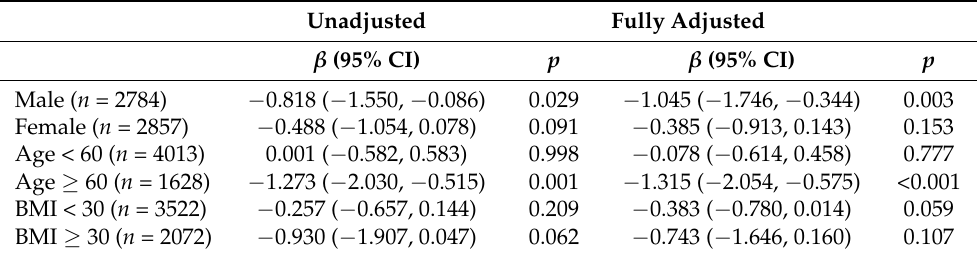
Table 3. Associations between serum selenium concentration and liver stiffness by gender, age, and BMI.